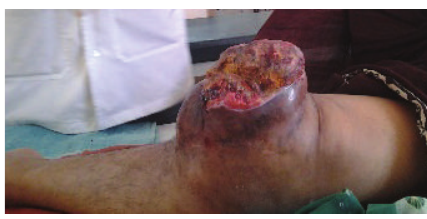
Figure 1: Ruptured tumor at the knee joint.